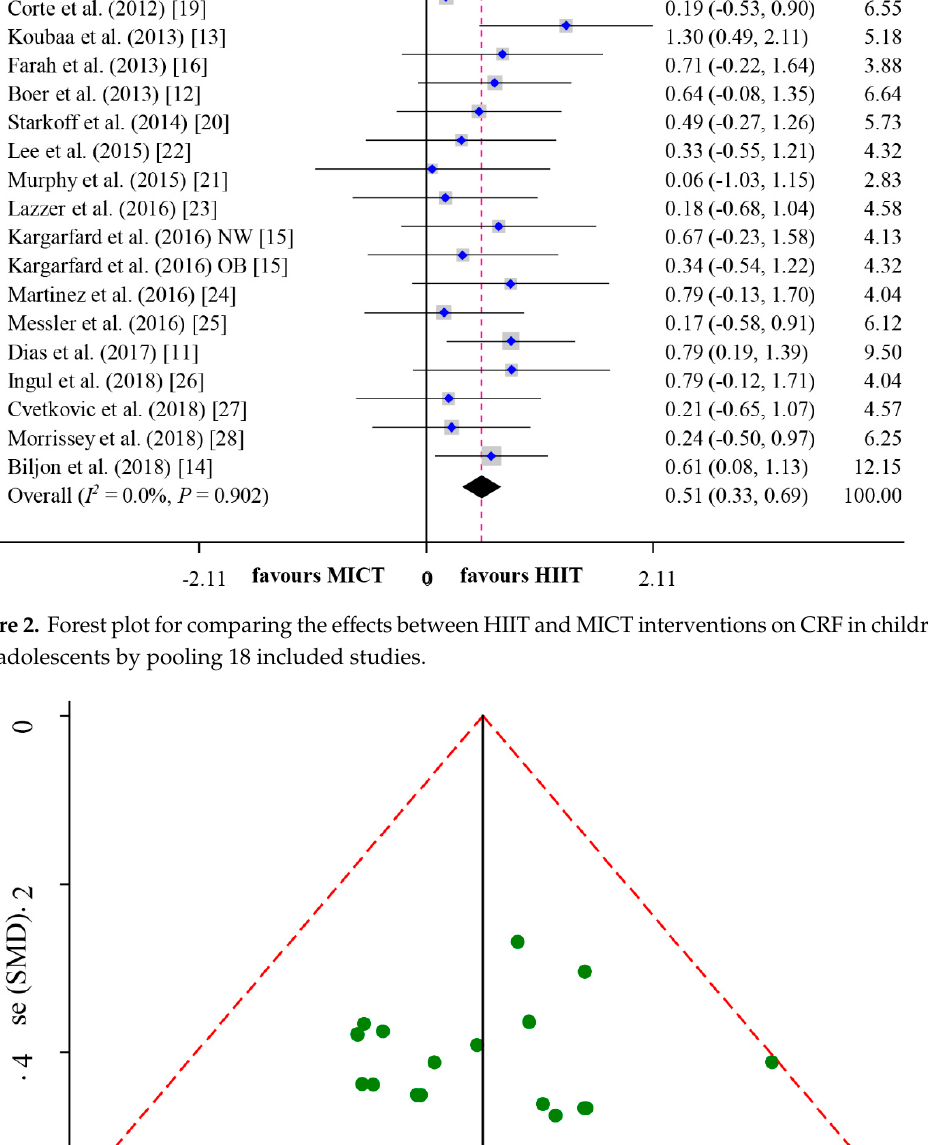
Figure 4. Results of trim and fill method (included 18 studies and 4 added studies).